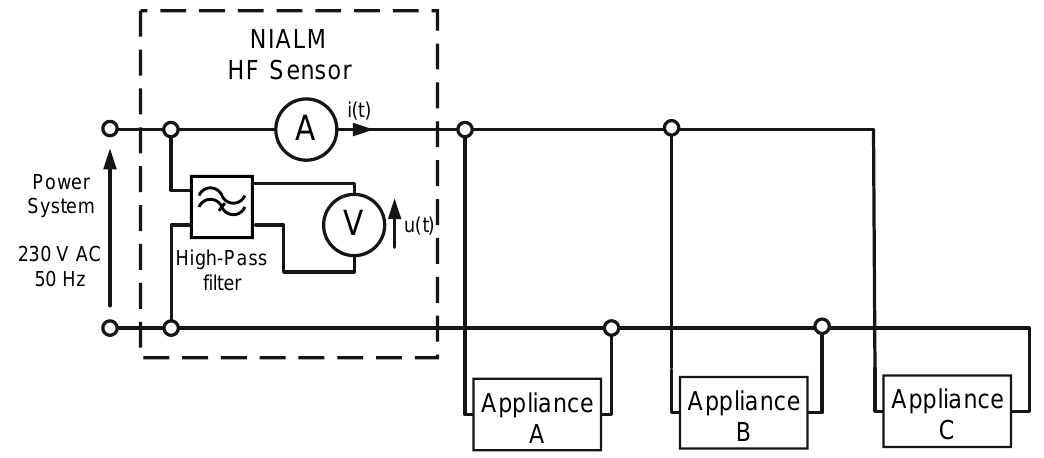
Figure 8. The block diagram of electromagnetic interference (EMI) measurement setup.